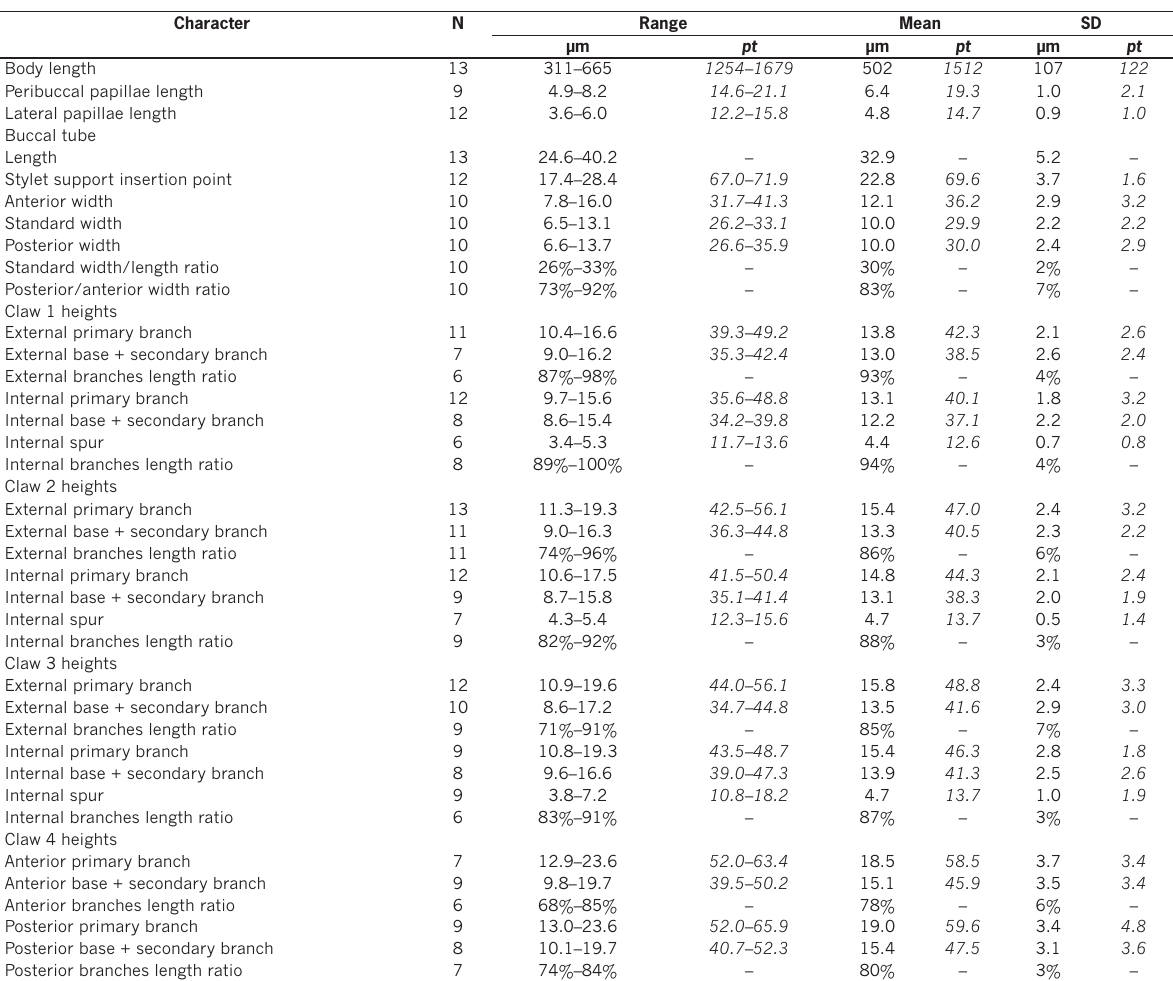
Table 3. Measurements (in μm) and the pt values of selected morphological structures of 13 adult females of Milnesium al- matyense Tumanov, 2006 from Kazakhstan, KZ.003, mounted in Hoyer’s medium. All available specimens were measured (N – number of specimens/structures measured, RANGE refers to the smallest and the largest structure amongst all measured spec - imens; SD – standard